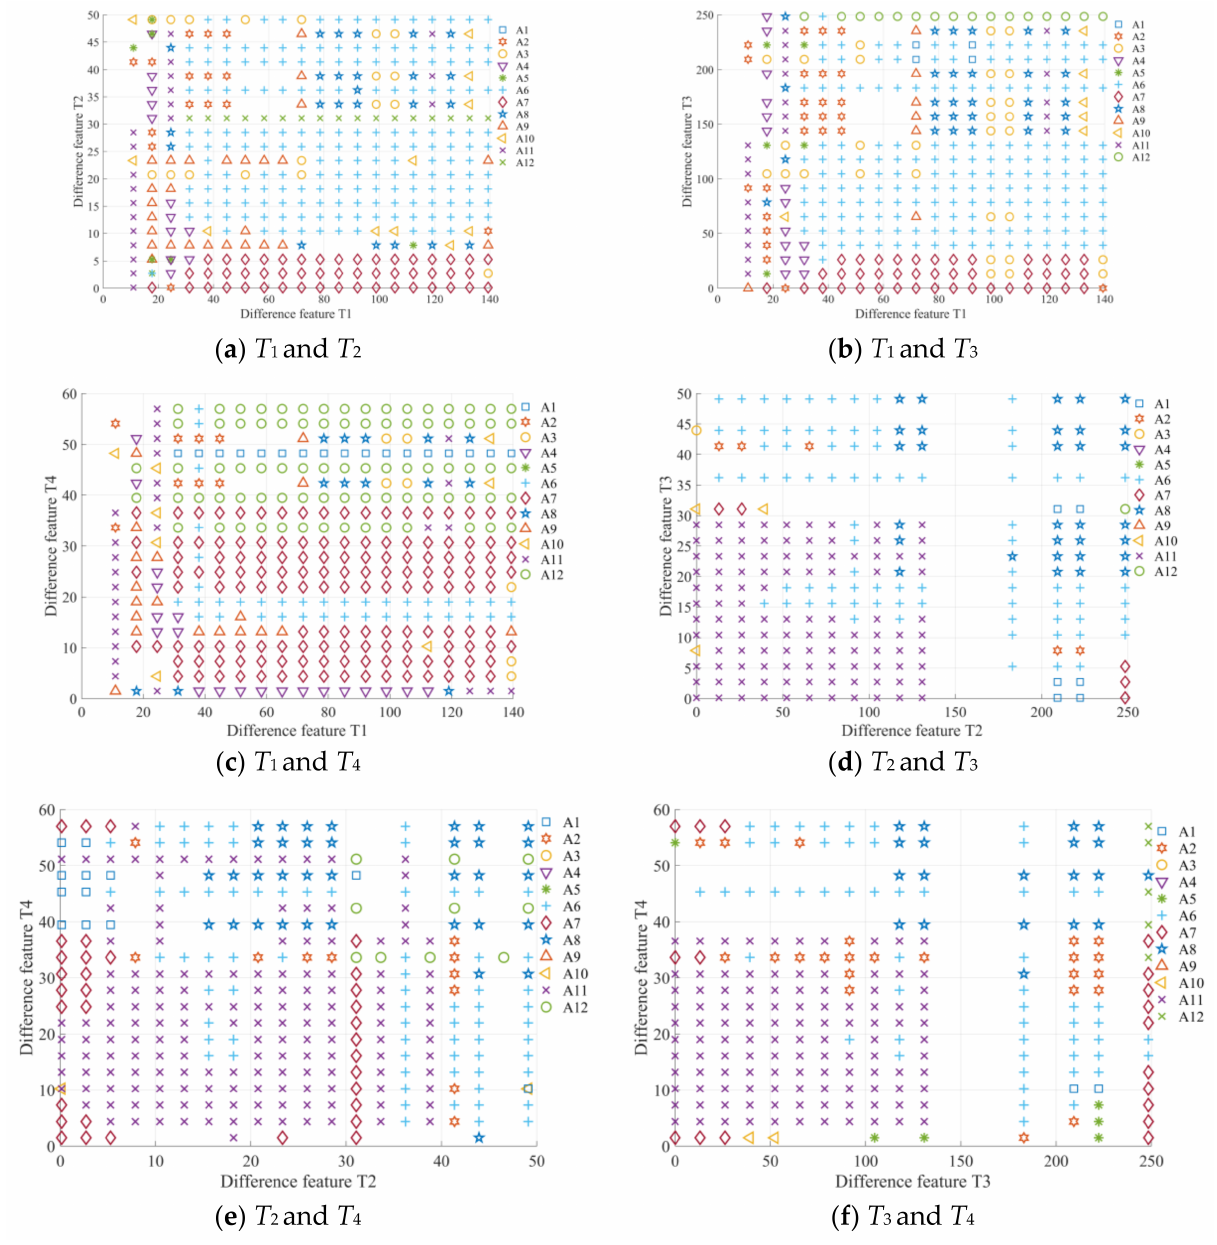
Figure 8. Joint drop shadow of difference feature score